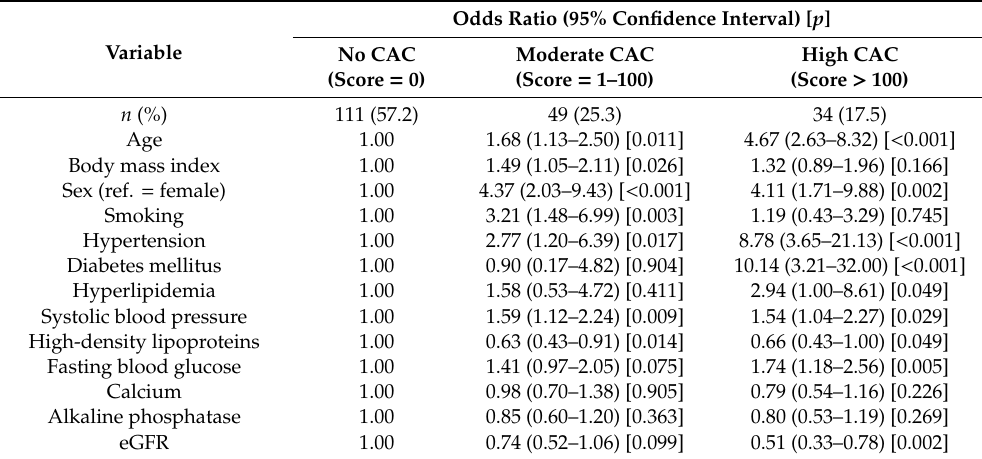
Table 2. Multinomial logistic regression analysis of the association of demographic and clinical variables with CAC in patients with osteopenia.